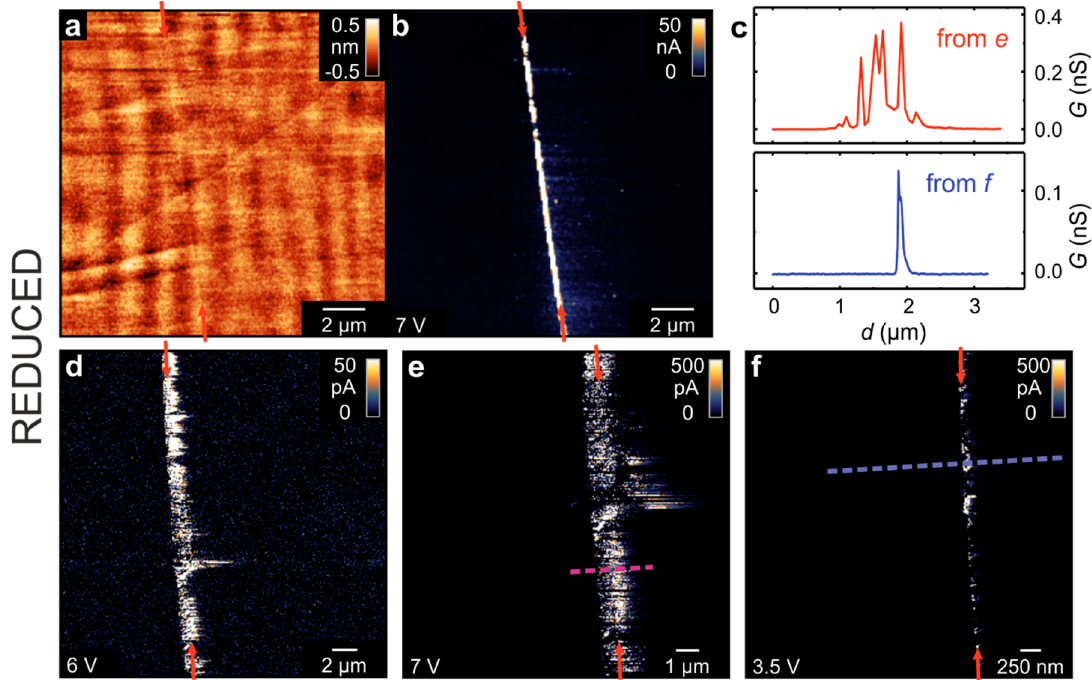
Figure 5. LC-AFM analysis of the 36.8° bicrystal junction after thermal reduction measured at room temperature. ( a ) Topography with ( b ) corresponding current map; ( d,e ) current maps obtained at different positions along the junction; ( c ) comparison of line profiles extracted from the current maps ( e ) and ( f ).